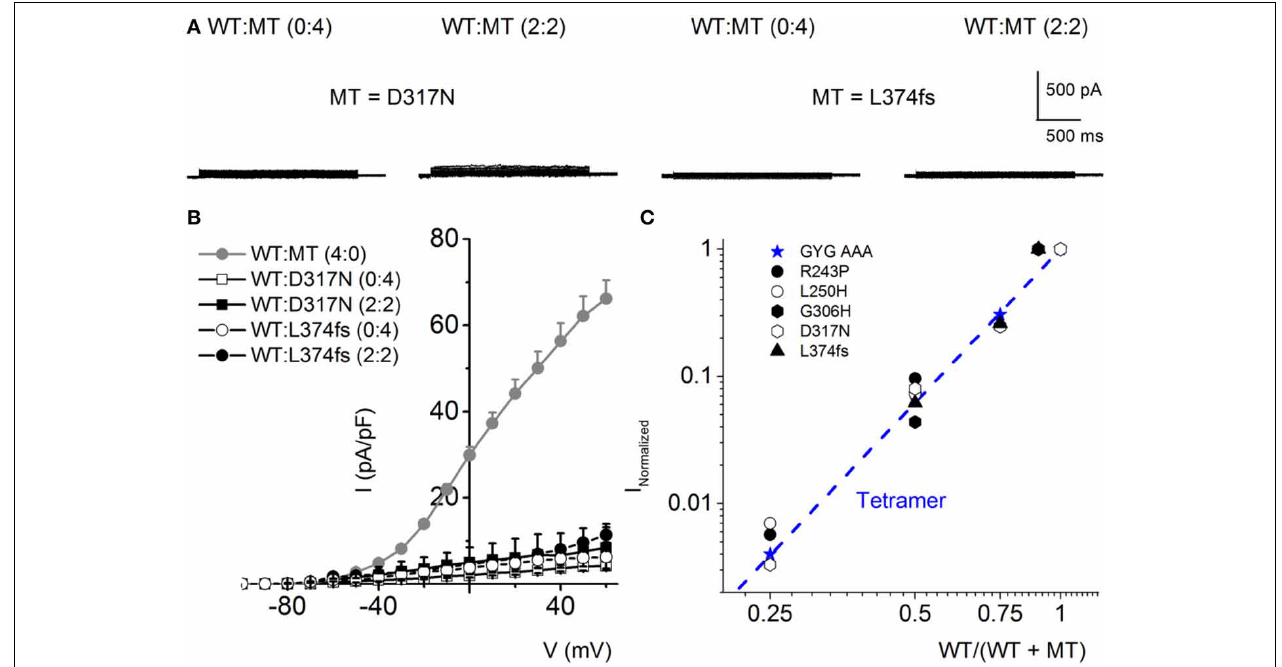
FIGURE 8 | RWS MT D317N and L374fs + 43X exhibit strong dominant negative effect on WT hKv7.1 channel functions. (A) Characteristic current traces recorded from a holding potential of − 80mV and activated from − 100 to 40mV with (cid:3) V of 10mV. The MT subunits (D317N and L374fs + 43X) when expressed alone did not produce measurable currents. Co-expression of the WT-hKv7.1 and MT subunits yielded little or no measurable currents.